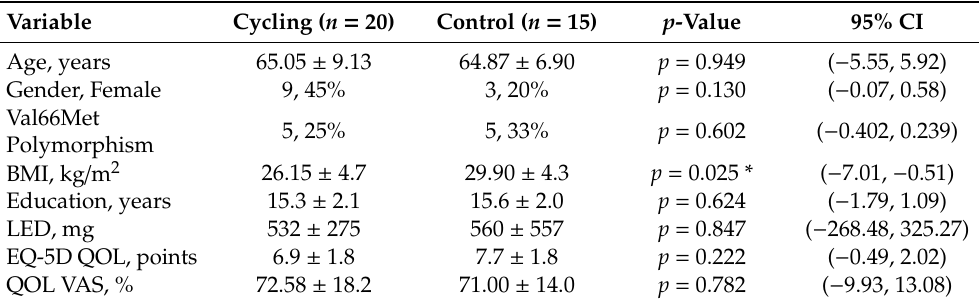
Table 1. Baseline participant characteristics.